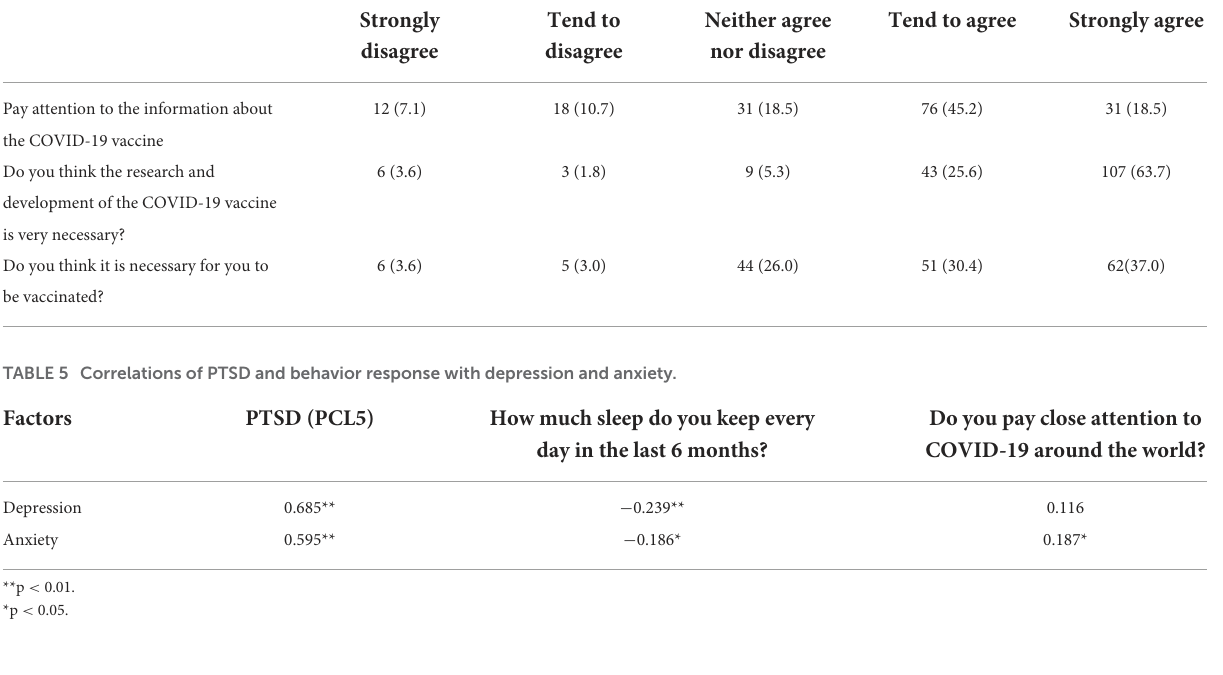
TABLE 6 Effects of behavior response on depression and